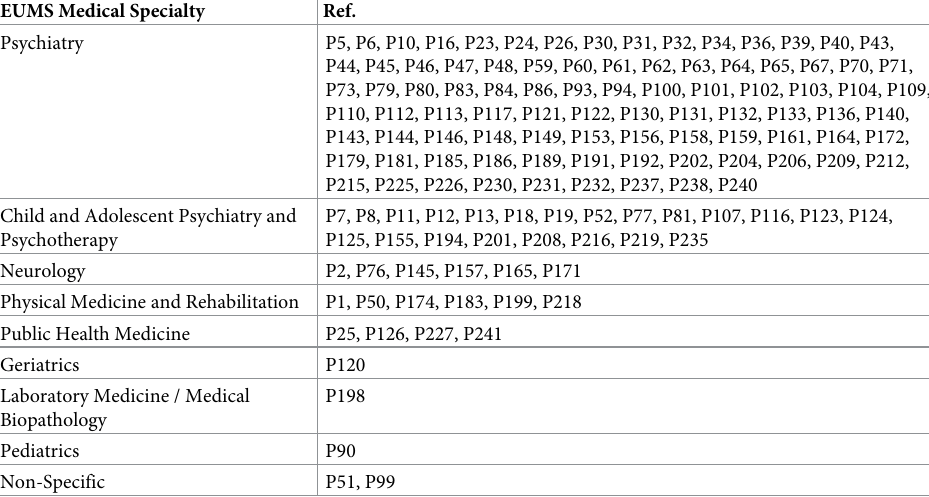
Table 1. References by EUMS medical